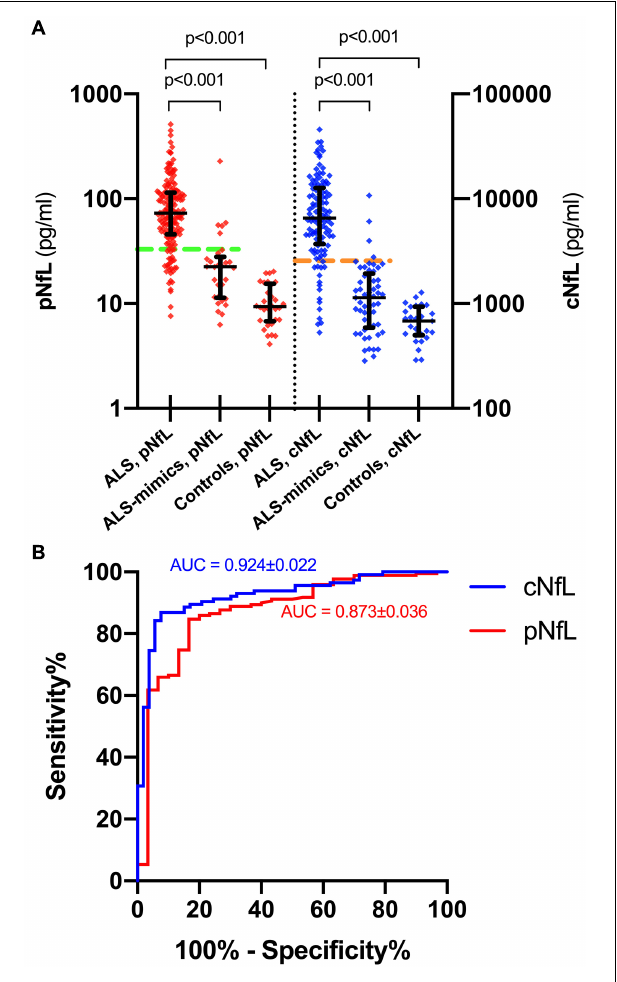
FIGURE 1 | pNfL and cNfL levels in the diagnostic groups and ROC curves for pNfL and cNfL. Both cNfL and pNfL demonstrate high diagnostic value in the distinction between ALS and ALS mimics. (A) pNfL and cNfL levels in ALS patients, ALS-mimics and control groups. Thick lines represent medians and interquartile ranges. Biomarker values are expressed in the logarithmic scale. Dotted horizontal lines indicate the optimal cut-off values for pNfL (green) and cNfL (orange) in the distinction between ALS and ALS-mimics patients, as calculated through the maximized Youden Index. Only p -values of significative comparisons are shown (Kruskal-Wallis followed by Dunn-Bonferroni post hoc test). (B) ROC curves for pNfL (red) and cNfL (blue) in the comparison between ALS patients and ALS-mimics. Key: cNfL, cerebrospinal fluid neurofilament light chain; pNfL, plasma neurofilament light